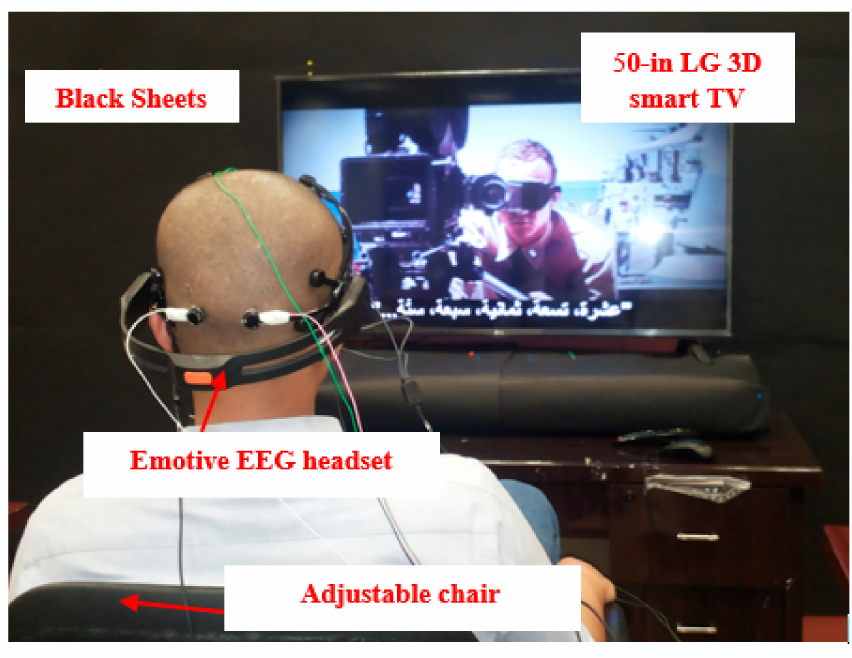
Figure 1. Experimental